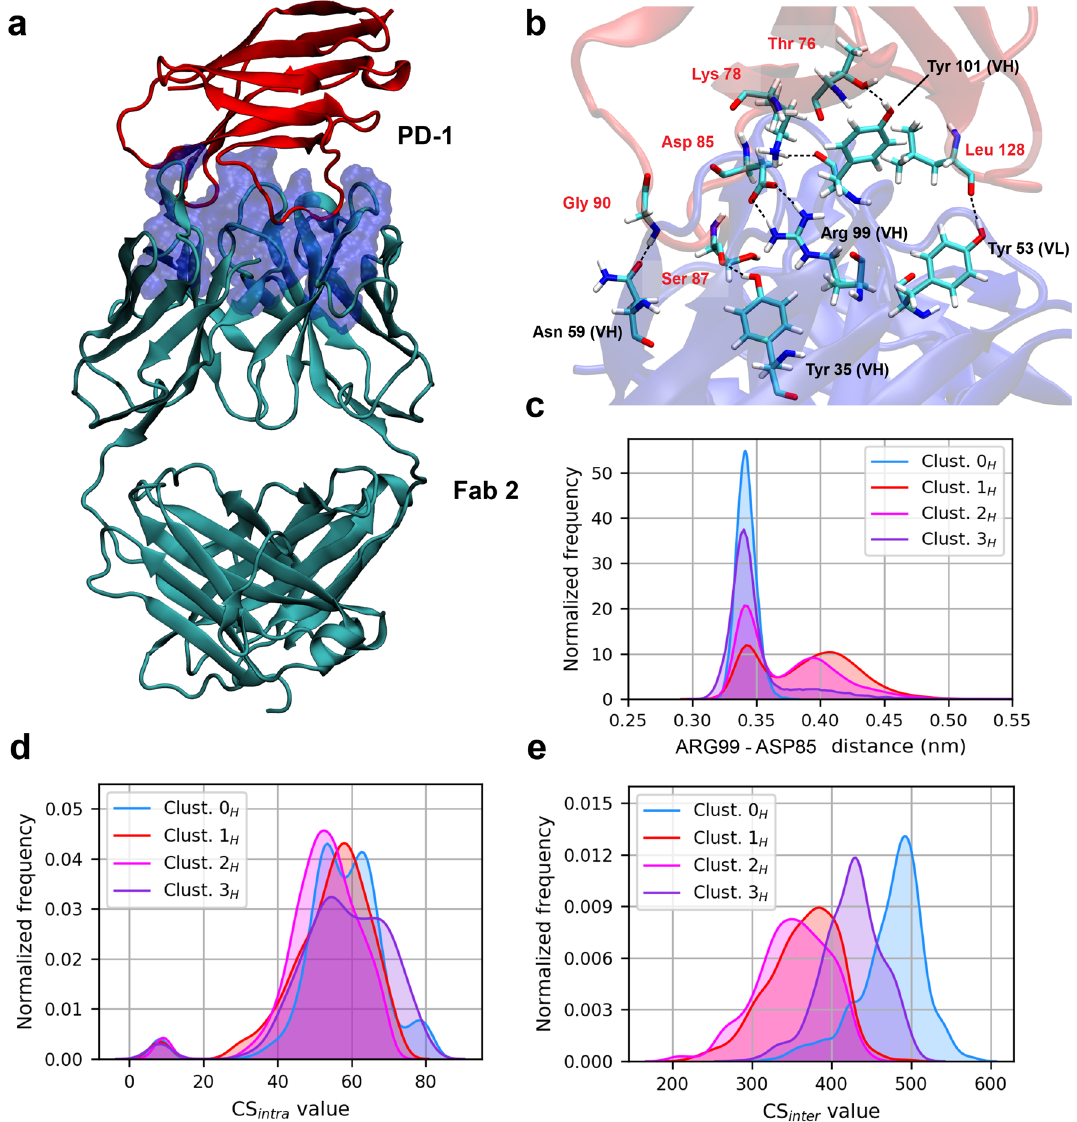
Figure 4. ( a ) Pembrolizumab Fab2 ( cyan ) in complex with PD-1 protein ( red ). The paratope is represented as a blue surface. ( b ) Residues involved in electrostatic interactions at the atigen/antibody interface; antigen residues are labelled in red. ( c ) Distance distributions between ARG99 in VH and ASP85 of PD-1. ( d ) Distributions of the intra- and inter- ( e ) domain correlation coefficients of antibody residues, for each conformational cluster of the holo